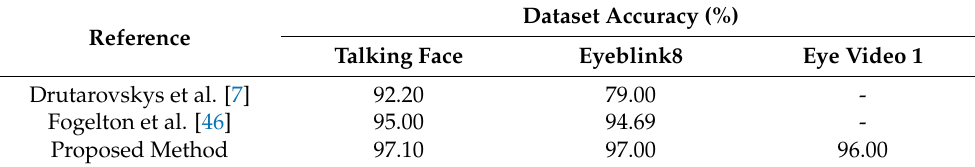
Table 7. Evaluation of the proposed method in comparison to existing